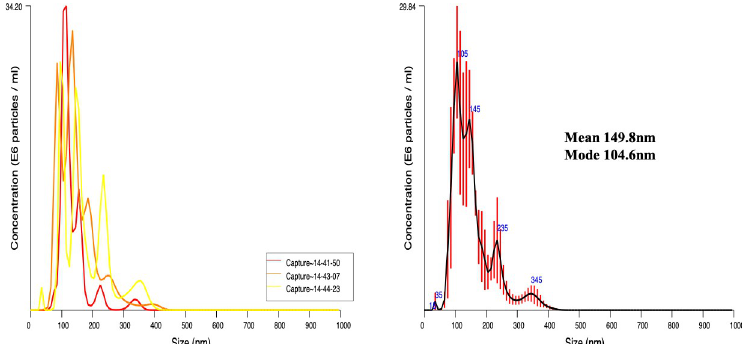
Fig 1. Characterization of mf-derived EVs. Live B . malayi mf were cultured for 24 hours at 37˚C in 5% CO 2 . EVs were then purified from the mf culture media. The profile of these isolated EVs was assessed using a NanoSight NS300 and NTA software. The majority of the EVs in the sample fall within the size range of exosomes.